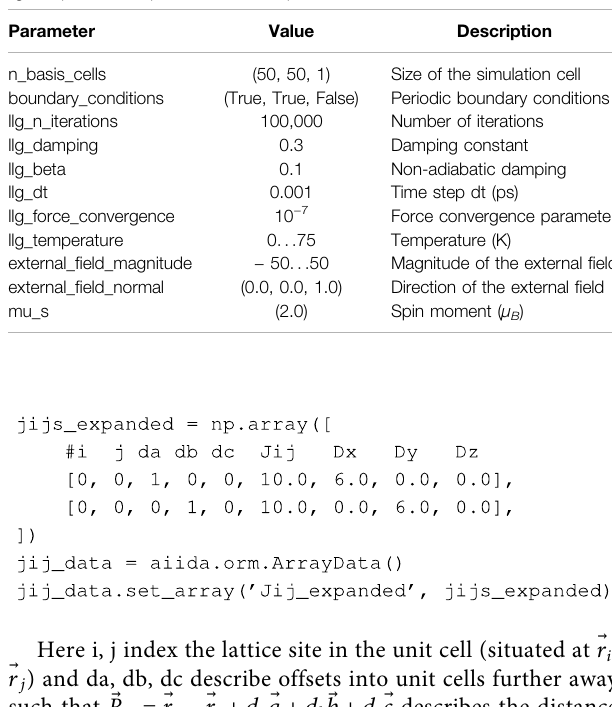
TABLE 1 | Parameters for the LLG calculations of the toy model. Arrays are indicated by the square brackets. Except for external_ fi eld_magnitude and llg_temperature all parameters are kept fi xed in the